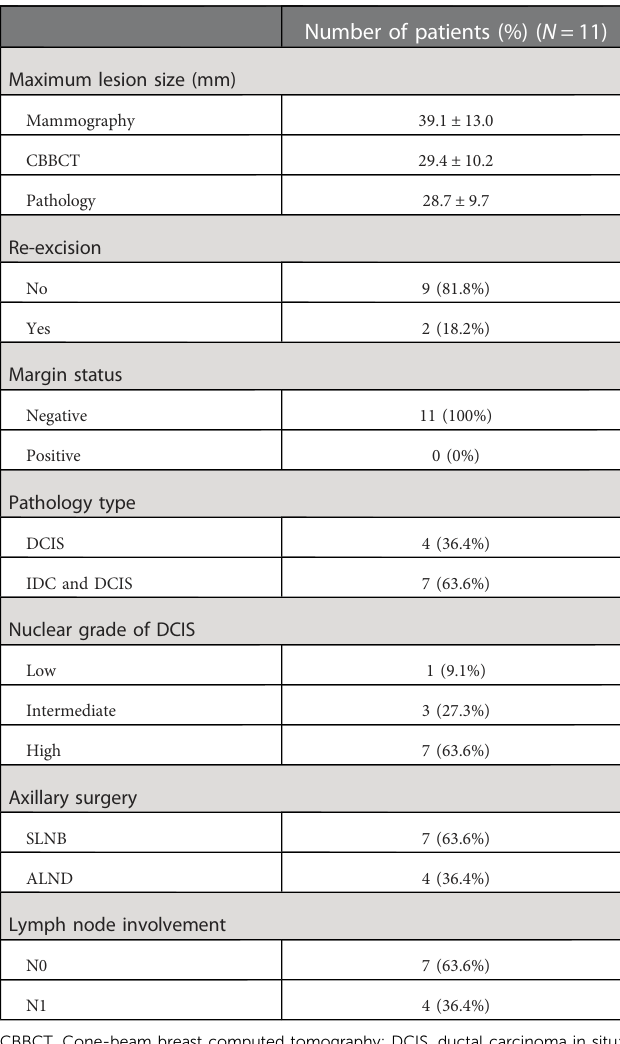
TABLE 1 Clinicopathological features of the enrolled patients. TABLE 2 Surgical outcomes of CBBCT-guided breast-conserving